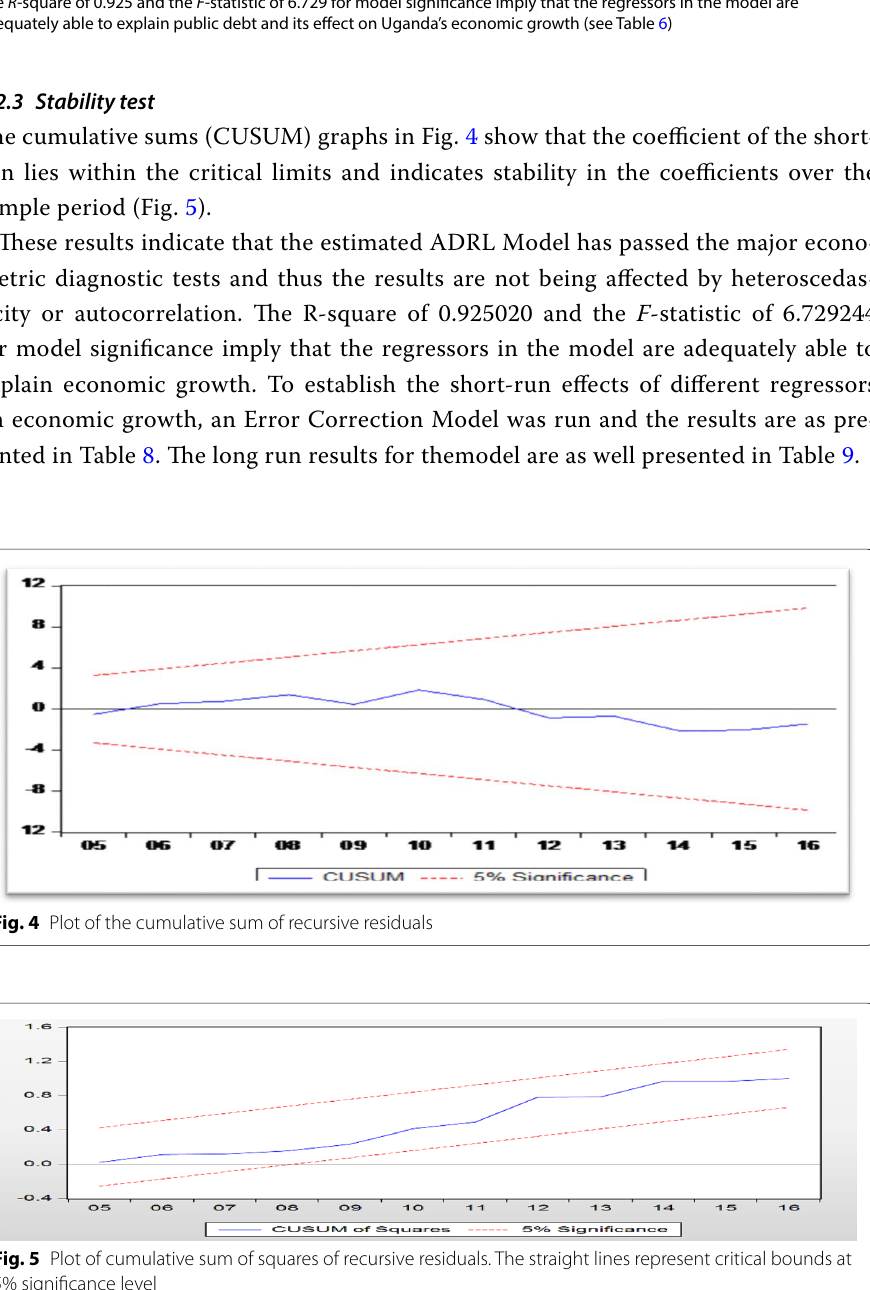
The R -square of 0.925 and the F -statistic of 6.729 for model significance imply that the regressors in the model are adequately able to explain public debt and its effect on Uganda’s economic growth (see Table 6)